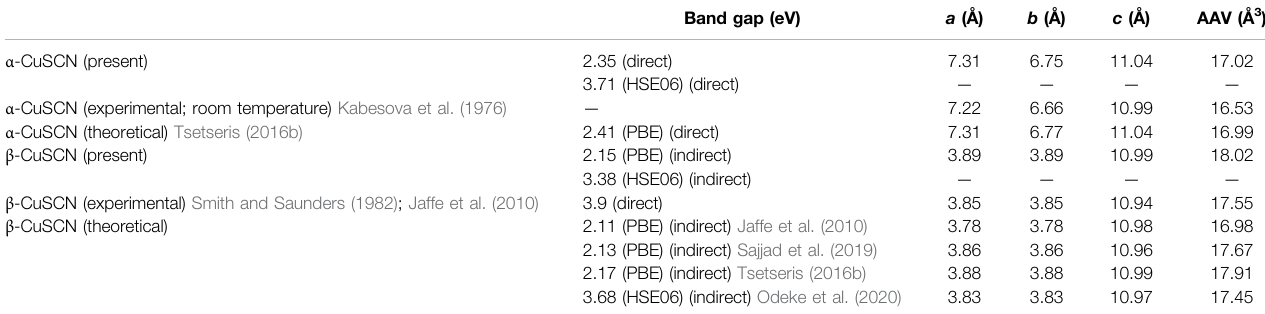
TABLE 1 | Calculated lattice parameters a , b , and c , bandgaps, and AAV of α -CuSCN and β -CuSCN. Available experimental and theoretical (PBE and HSE06 functionals used) results were also listed for comparison.